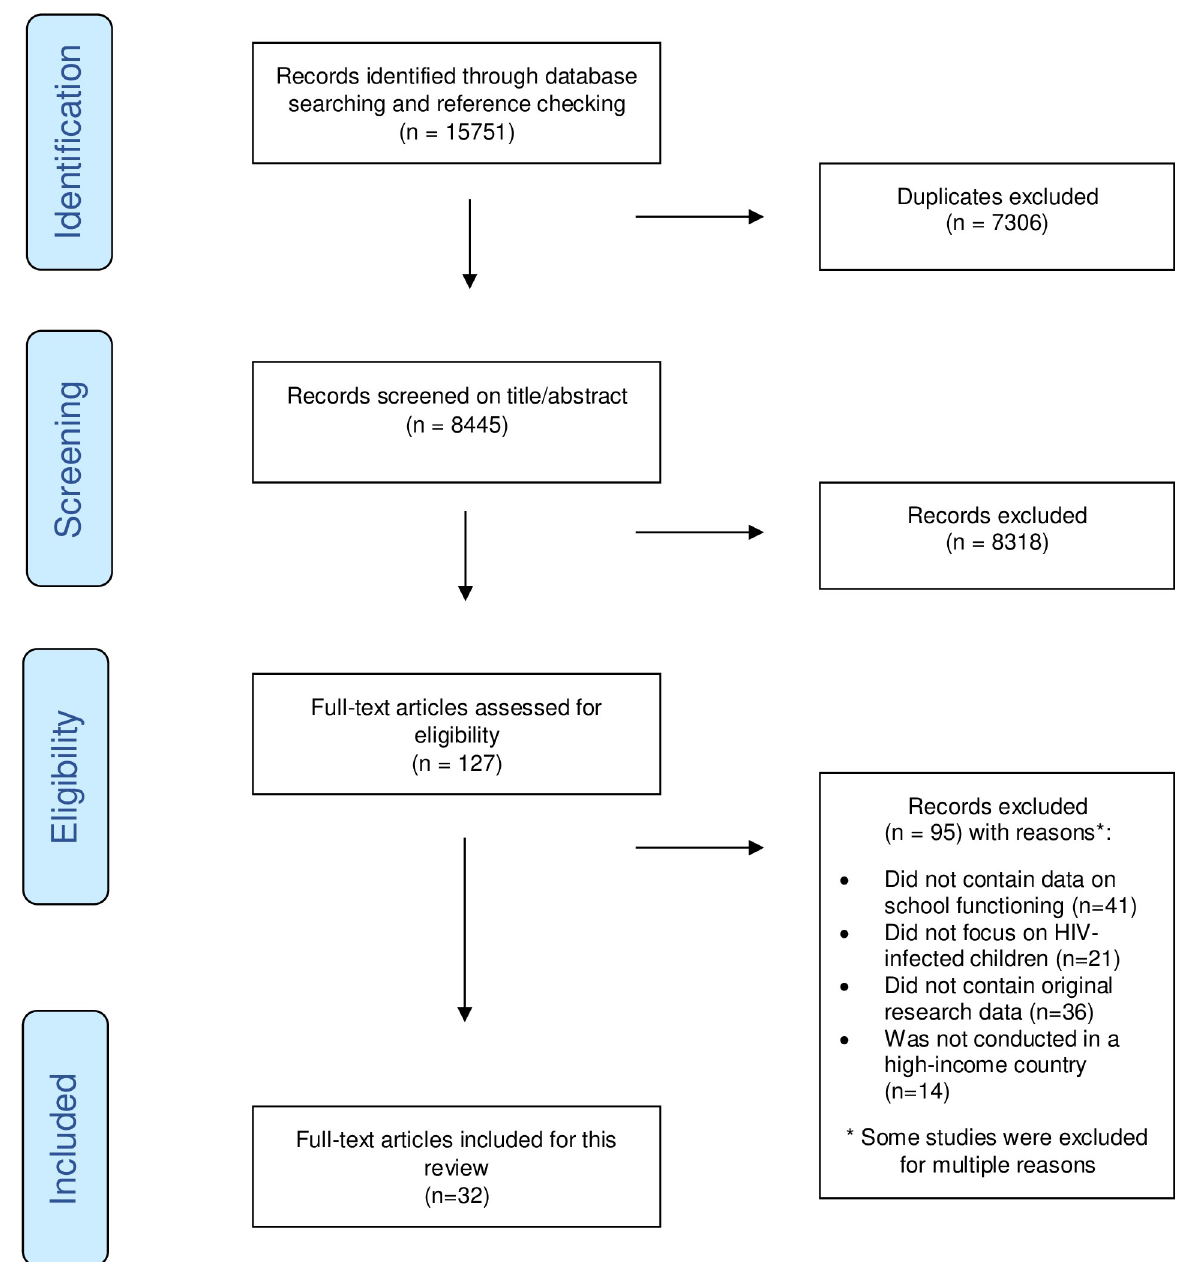
Fig 1. Selection of eligible